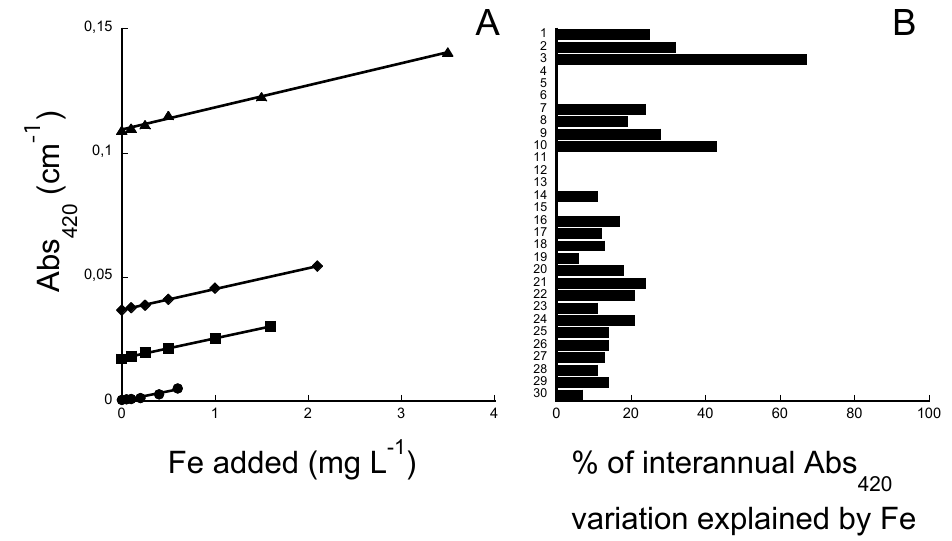
Fig. 7. The theoretical contribution of Fe to Abs 420 . Panel A shows the effect of Fe additions on water color as measured by Abs 420 in water from Lake Lindhultsg¨ol ( N ), River Lagan ( (cid:7) ), Lake Holmeshultasj¨on ( (cid:4) ) and River Motala Str¨om ( • ) respectively. All regressions are significant ( p < 0 . 001). The slope and r 2 of the regression equations and water chemistry of the different waters are shown in Table 3. Panel B shows how much of the inter-annual variation in Abs 420 that could theoretically be explained by variation in Fe for each river. This fraction is calculated by comparing the slope of the Abs 420 – Fe relationship in each river to that of the experimental Fe addition (the mean of the four slopes derived from the experiment, 0.0083cm − 1 mgFe − 1 ) . Table 3. Chemistry of the waters used for the Fe addition experiment and the regression equation with r 2 -values for the increase in absorbance in response to Fe addition for the respective waters (visualized in Fig. 7). Origin pH DOC Fe Abs 420 Regression slope r 2 of